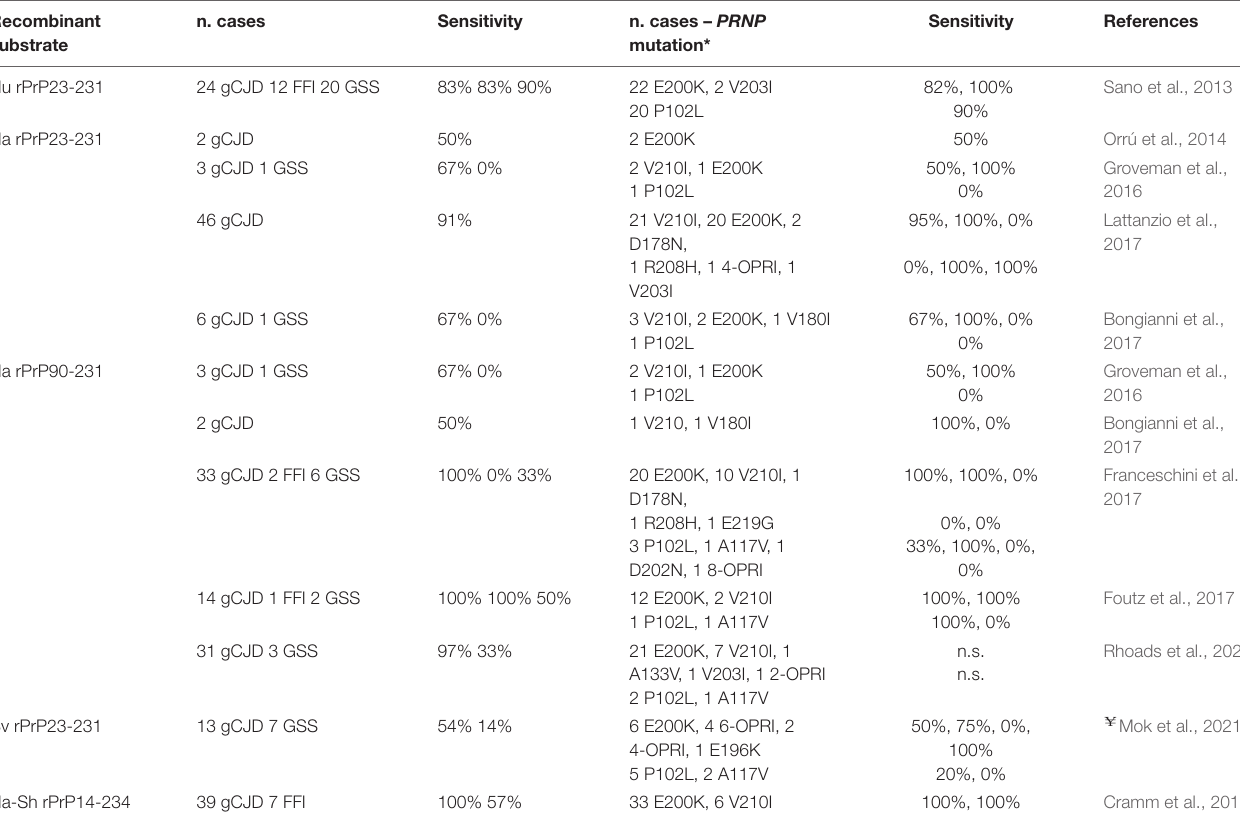
TABLE 6 | Performance of CSF-RT-QuIC in genetic prion diseases according to phenotype and PRNP mutation. Recombinant n. substrate